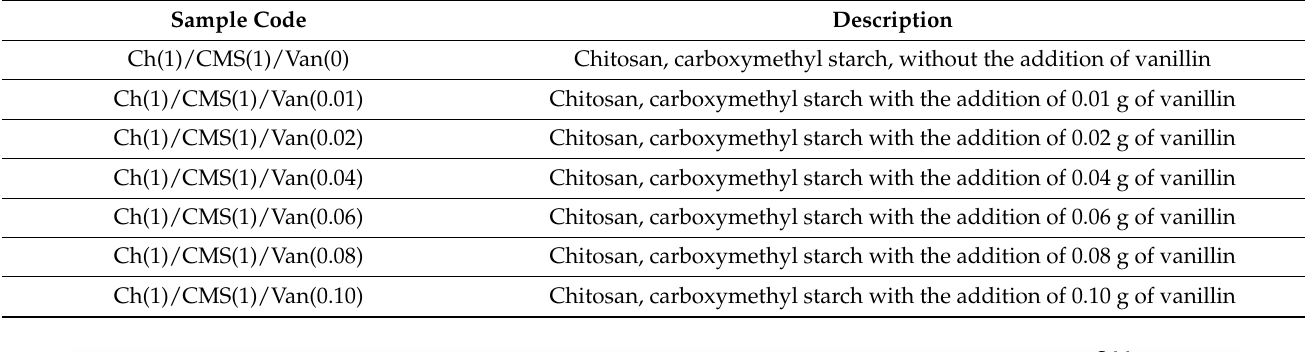
Figure 14. Synthesized carboxymethyl starch ( a ) immediately after precipitation with ethanol; ( b ) cut into 5 × 5 mm pieces; ( c ) dried in a vacuum oven. Table 14. Explanation of polymer sample codes.